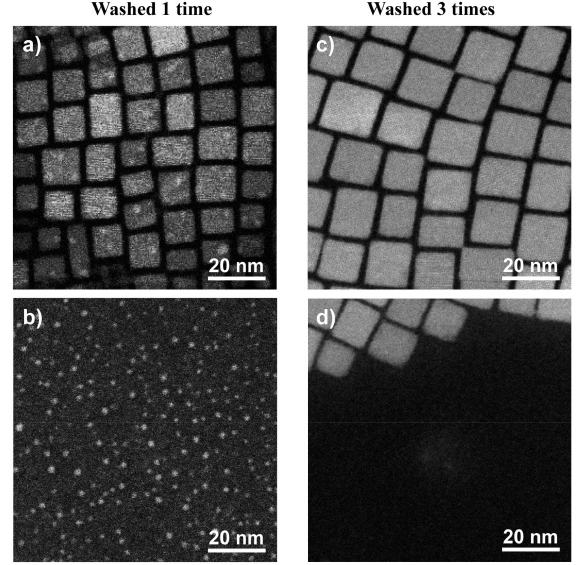
Figure 7. HAADF-STEM images of the distribution of the NPs on both CsPbBr 3 NCs and carbon films for the sample washed one time ( a , b ) and the sample washed three times ( c , d ),